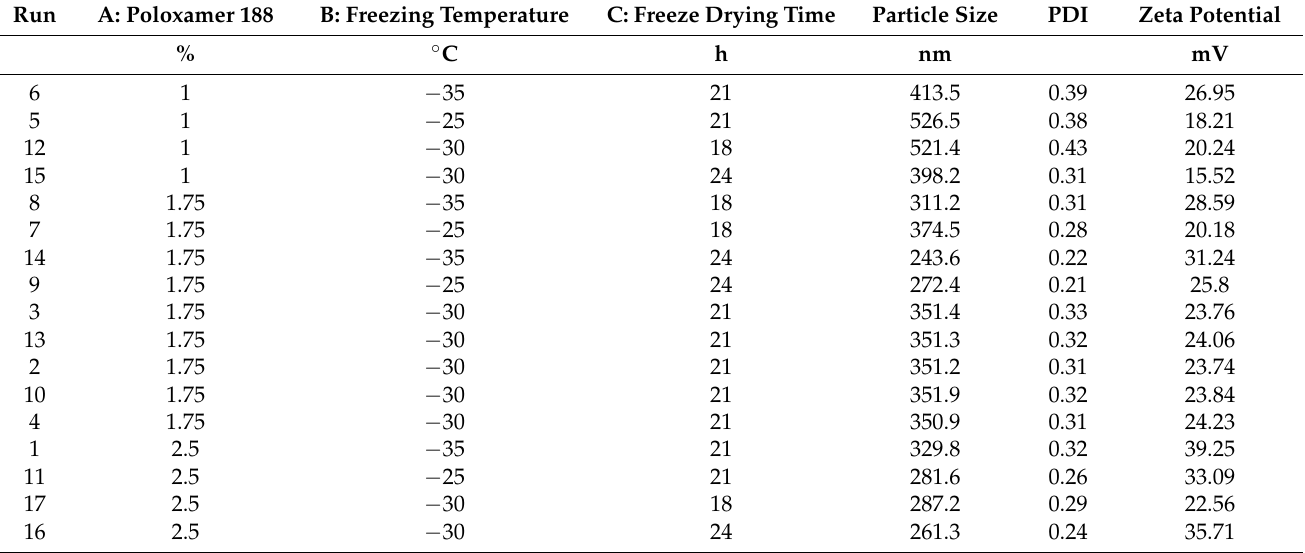
Table 2. Experimental runs projected and their responses observed.